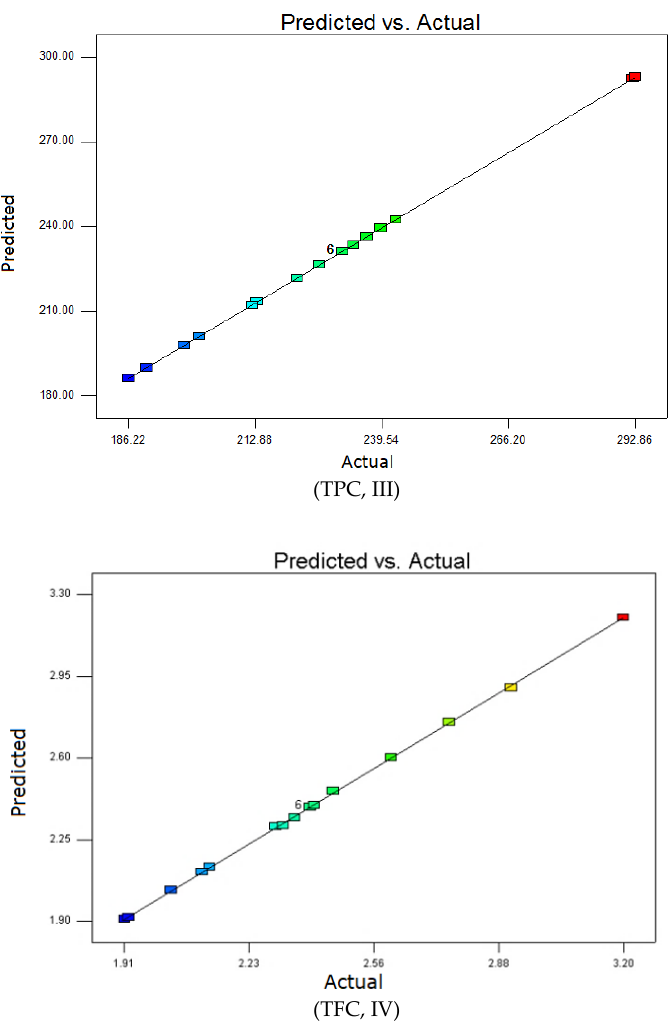
Figure 1. The fitted line plot signifying the closeness between predicted values and experimental values for (DPPH, I), (FRAP, II), (TPC, III) and (TFC, IV). values for (DPPH, I), (FRAP, II), (TPC, III) and (TFC,